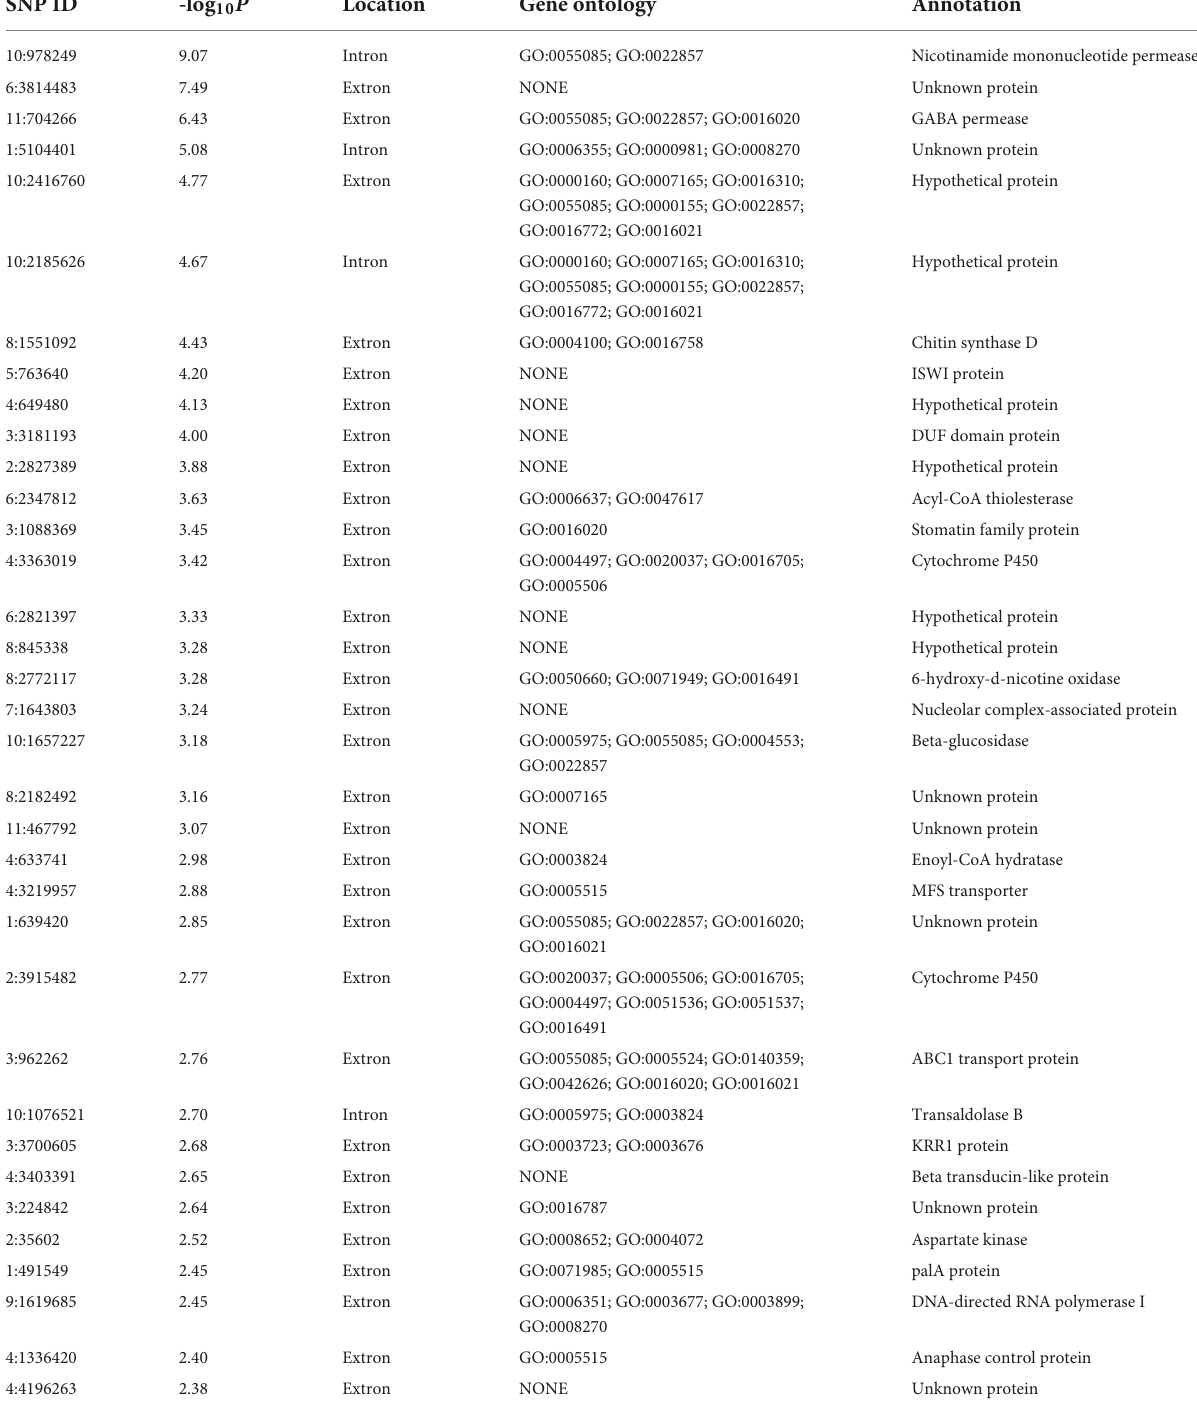
TABLE 3 Top 35 candidate genes significantly associated with FB1 production in Fusarium